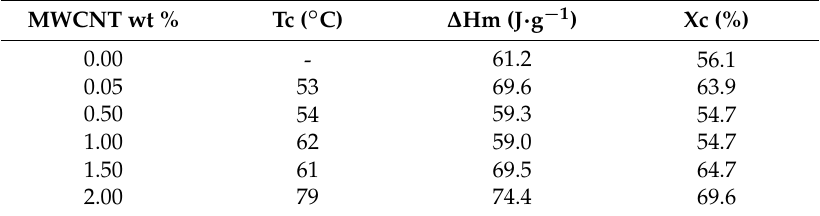
Table 1. Values of melting enthalpy ( ∆ Hm) and degree of crystallinity (Xc) in PHBV/MWCNT nanocomposites.